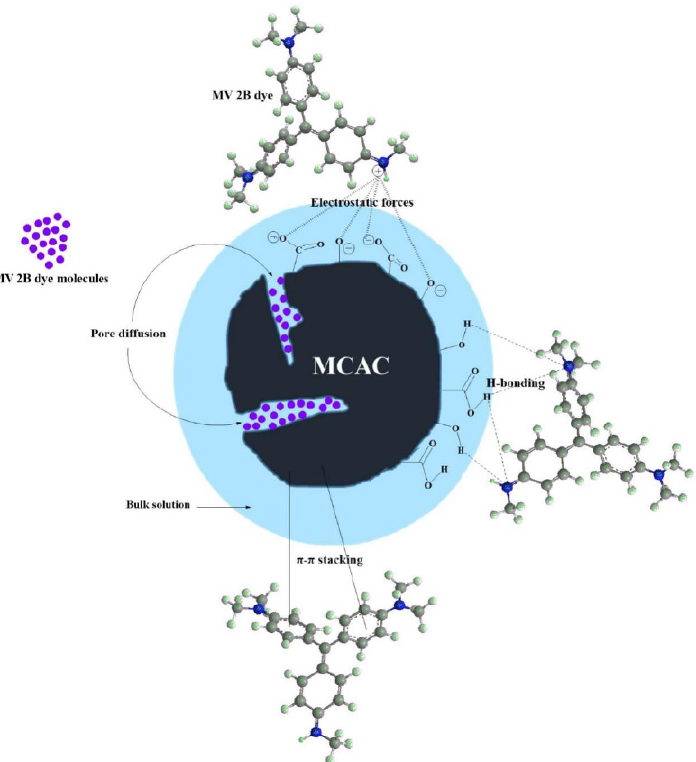
Figure 8. Illustration of the possible interaction that occur between the MCAC surface and MV 2B including electrostatic interactions, hydrogen bonding, pore diffusion, π - π stacking along with pore diffusion.